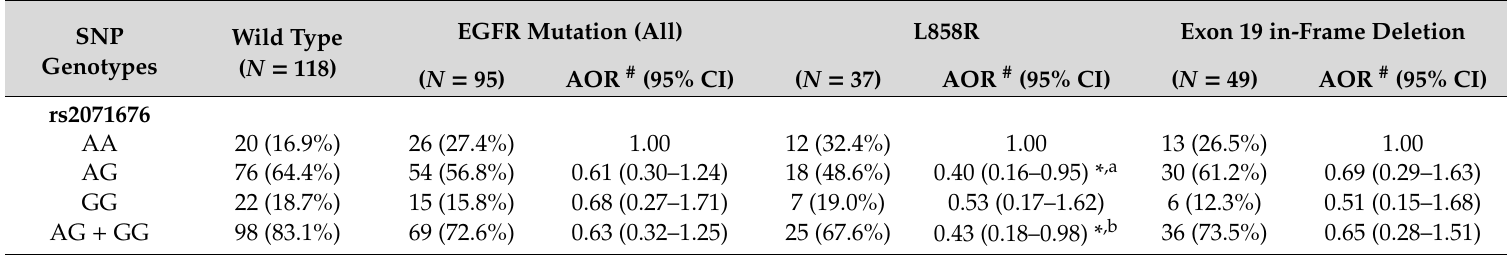
Table 3. Distribution frequency of carbonic anhydrase 9 genotypes of 213 male patients with lung adenocarcinoma and multiple logistic regression analysis of epidermal growth factor receptor mutation